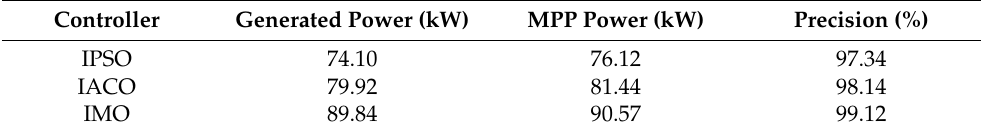
Table 1. Comparative analysis of various controllers in terms of PV source.